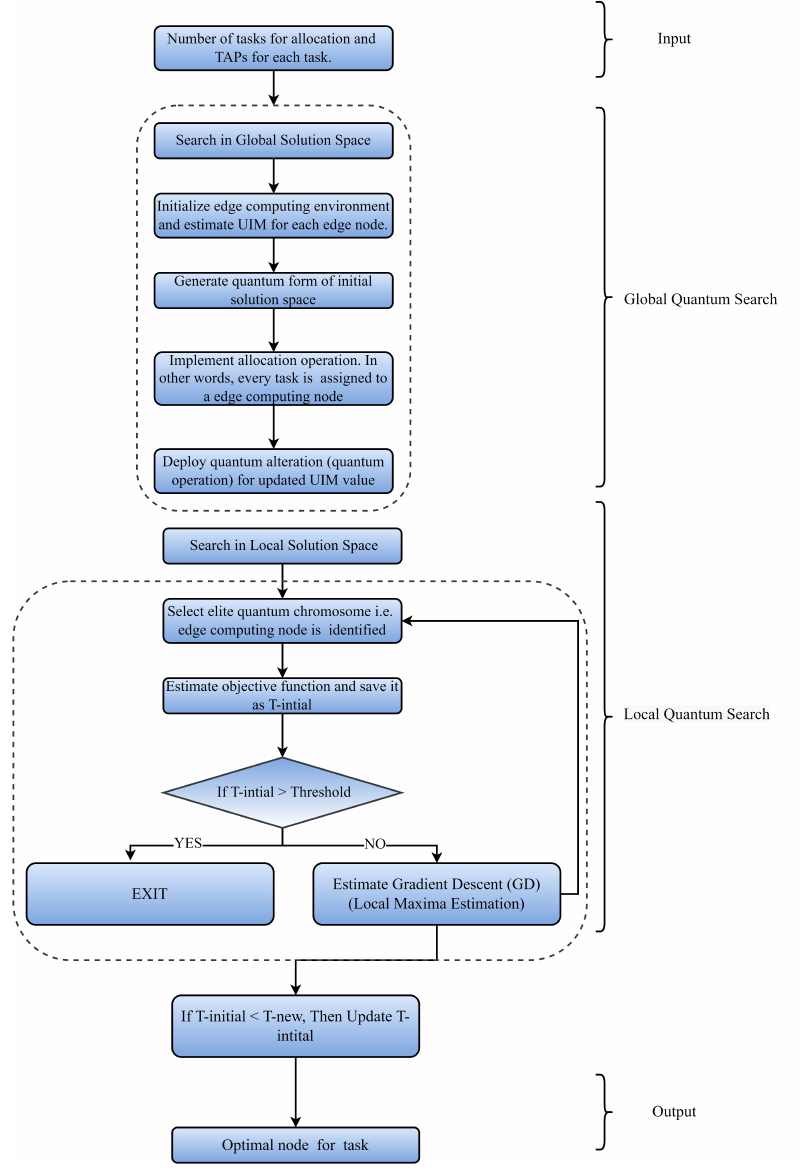
Figure 5. QCi-Algorithm for Task